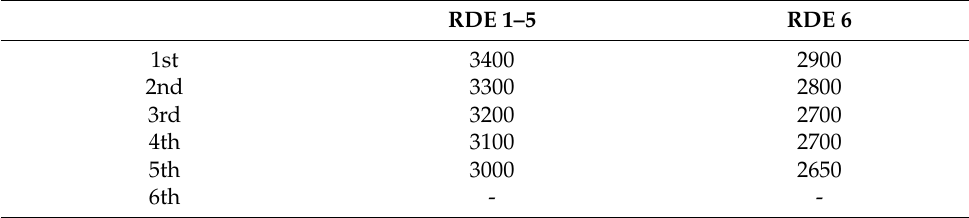
Table 3. Maximum engine speed limits for each